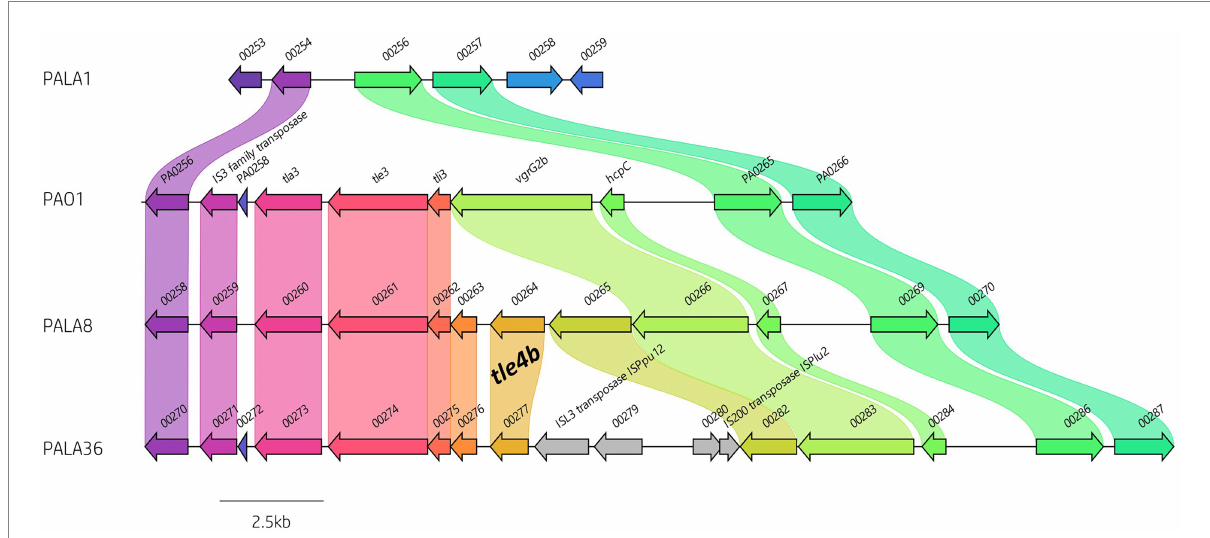
FIGURE 7 Comparative visualisation of the vgrG2b island highlighting the variable genetic architecture of this region in the genomes of different strains. PAO1 is the representative island example. Isolate PALA1 lacks the vgrG2b island. Isolate PALA8 possesses an additional gene encoding the putative T6SS effector tle4b (PALA8_00264) within the vgrG2b island. Isolate PALA36 is an example of the insertion of transposons into the island. Genes coloured the same with connected bands are homologs. Genes found in only one genome are in grey arrow. Arrowheads represent gene direction for transcription. Figure generated using Clinker (Gilchrist and Chooi,